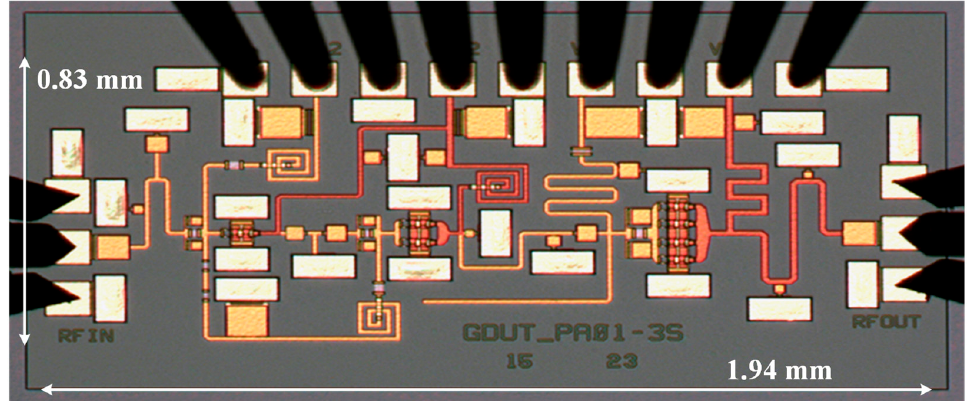
Figure 16. Die microphotograph of the 24–30 GHz GaN MMIC PA.